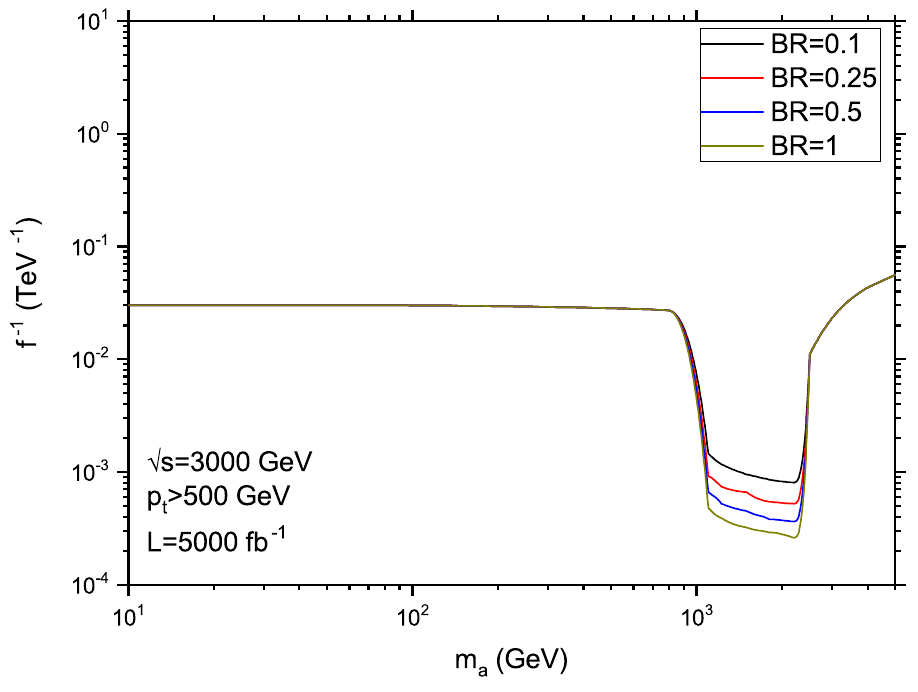
Figure 6 . The as in figure 5, but for √ s = 3000 GeV and L = 5000 fb − 1 .